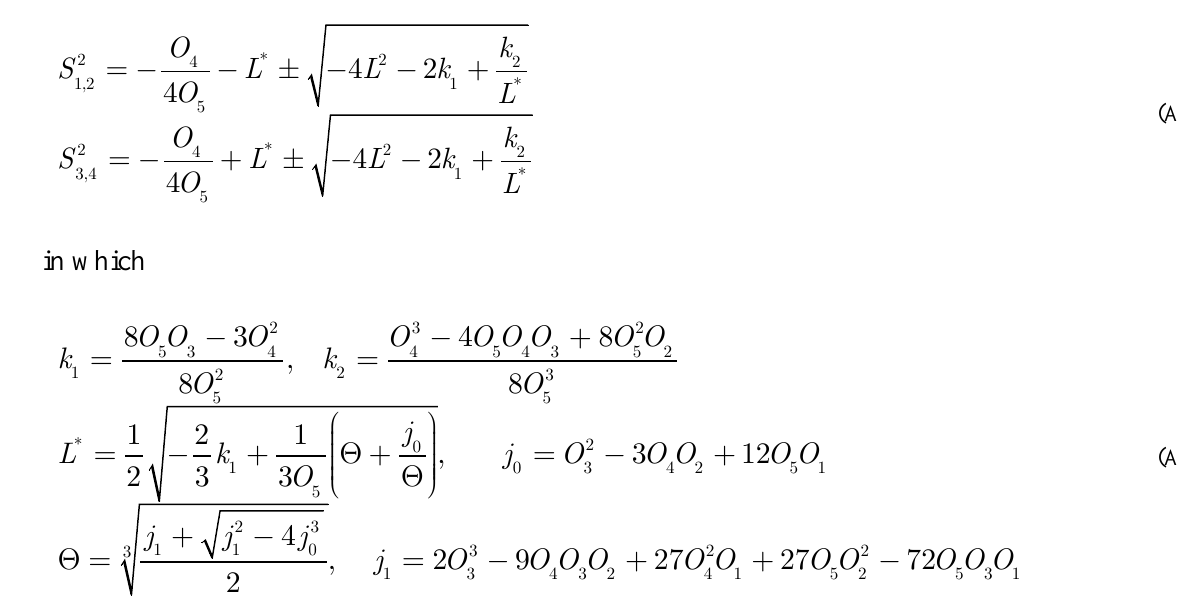
Table A1. Normalized elasticity coefficients of synthetic transversely isotropic materials with respect to elastic parameters of isotropic material given in Table A2 Material No.